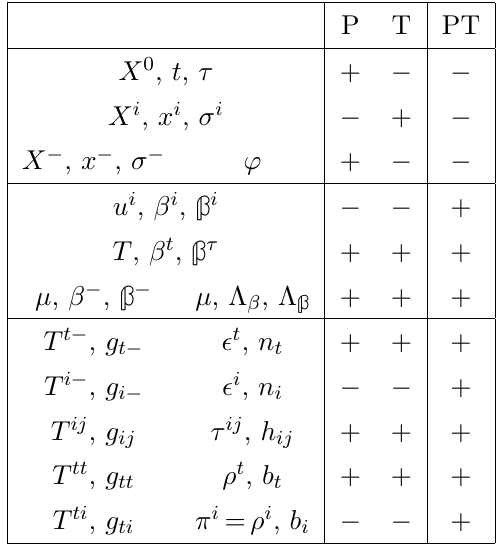
Table 1 . Action of parity (P) and time-reversal (T) on various quantities in classical Galilean hydrodynamics and e(cid:11)ective (cid:12)eld theory. Schwinger-Keldysh double copies of various quantities in the e(cid:11)ective theory, \1 = 2" or \ r=a ", behave the same as their unlabelled